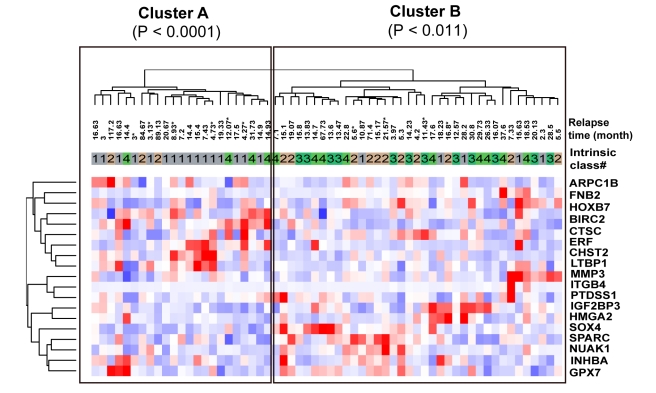
Expression pattern of miR-204 targets identified a subtype of HNSCC tumors exhibiting an EGFR-pathway signature and miR-204 was deregulated in other squamous and epithelial tumors.miR-204 functional targets classified 60 HNSCC tumors in (GSE686) [41] microarray based on their intrinsic properties (Methods). P-values were obtained using a Fisher's exact test; *: censored data.